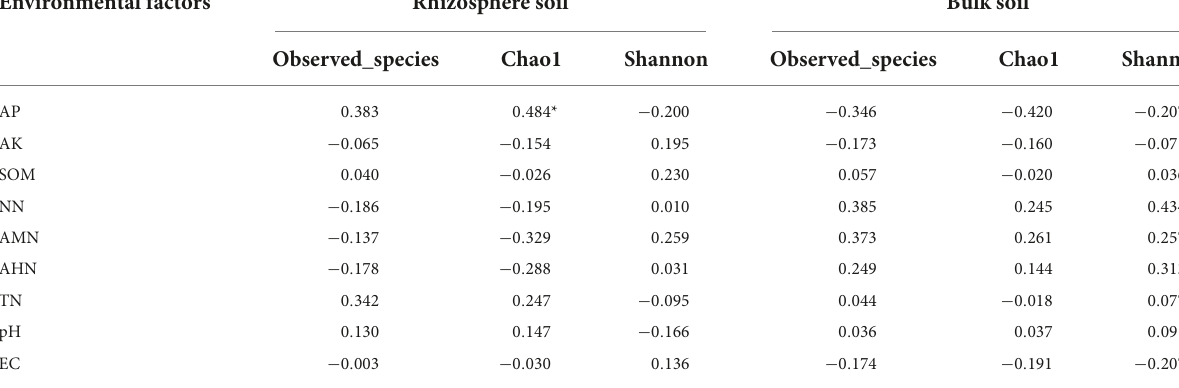
TABLE 4 Correlations Analysis between bacterial alpha-diversity and soil physicochemical properties. Environmental